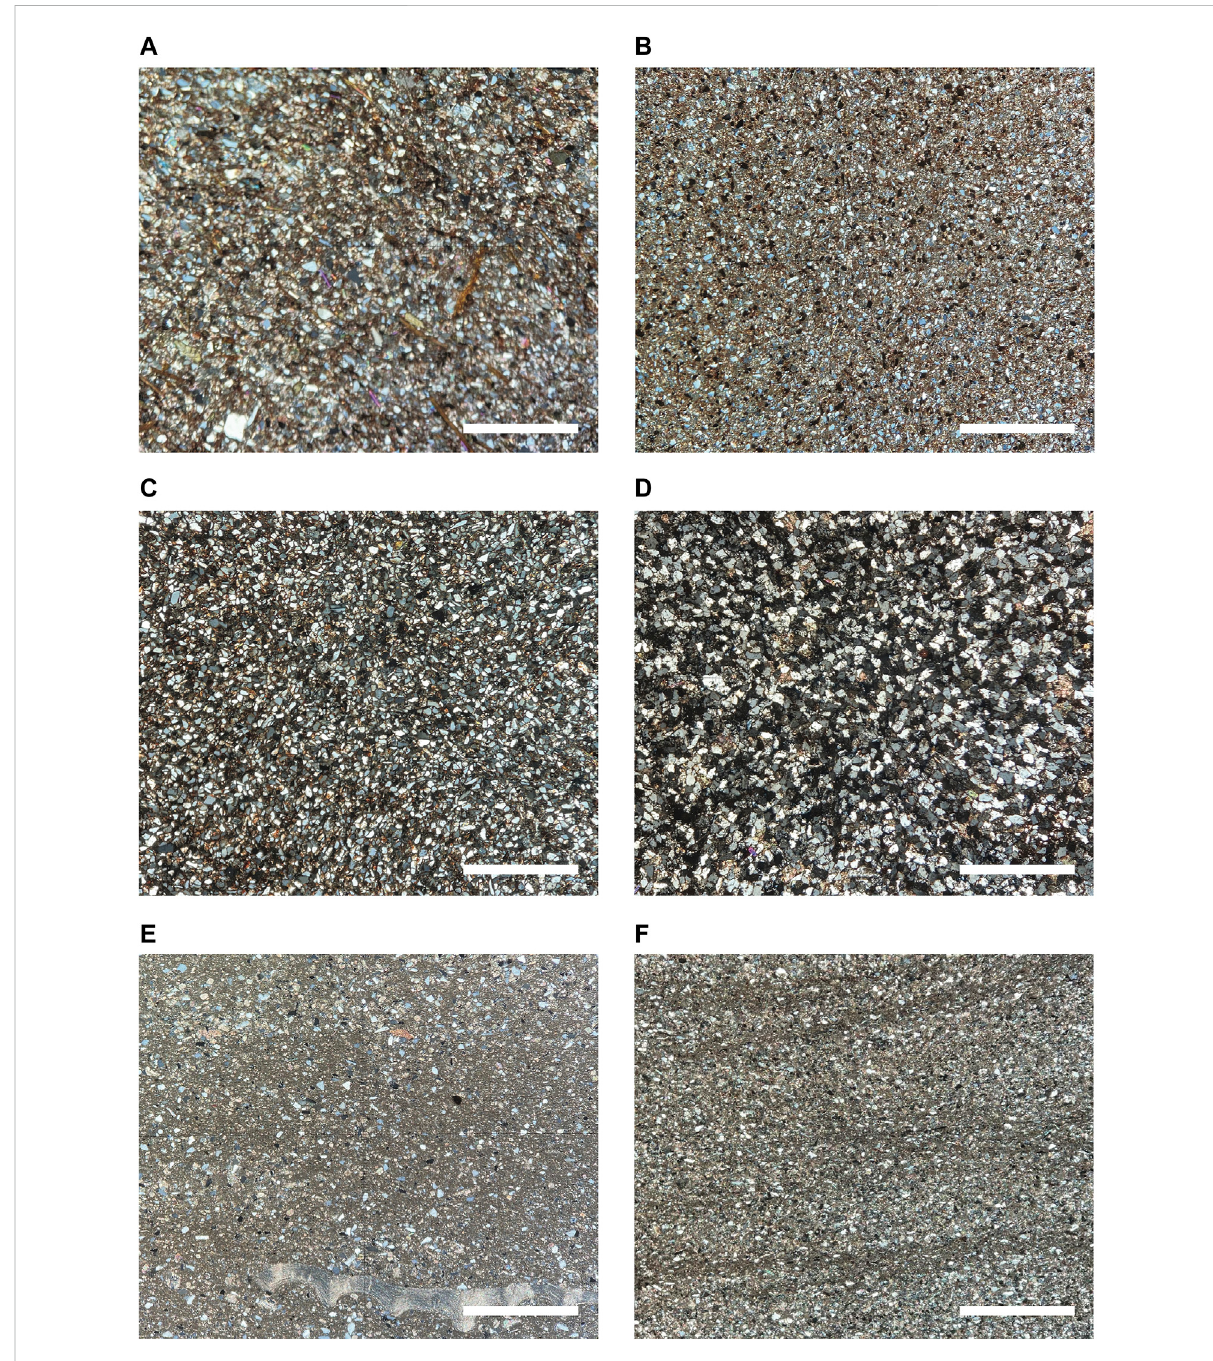
FIGURE 7 Micromorphological (thin section) attributes of loess and eolian-transported dust in assorted Upper Pennsylvanian-Permian formations in the western United States including (A,B) proximal and distal Cutler Formation loessite (Colorado and Utah, respectively), (C) Tubb Formation loessite (New Mexico), (D) Maroon Formation loessite (Colorado), and (E,F) quartz silt (dust) in the marine Naco Formation (Arizona). All scalebars are 2